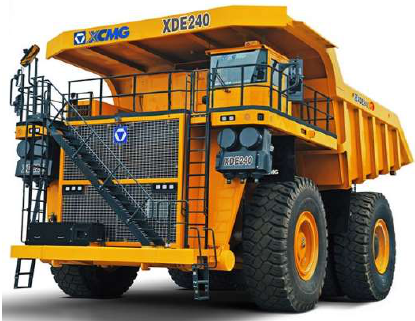
Figure 1. Typical electric-drive